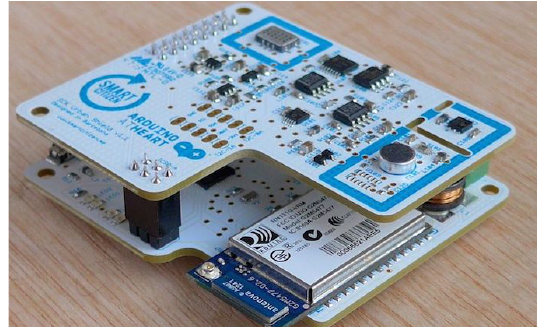
Figure 1. The SCK sensor